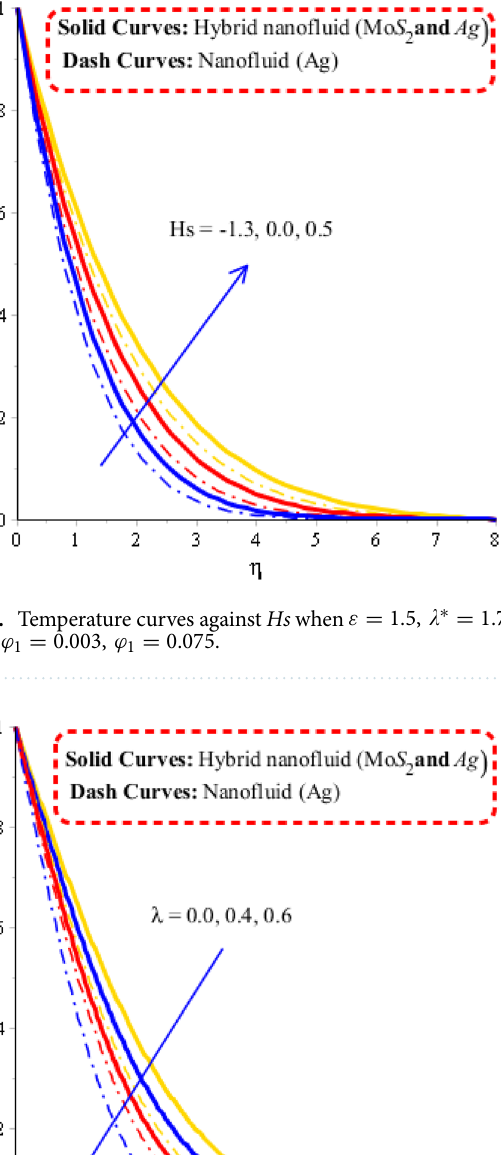
0.2, (cid:31) 0.4, γ 2.3, Fr 0.5, Pr 204, Hs 2.3, ∗ = = = = = =